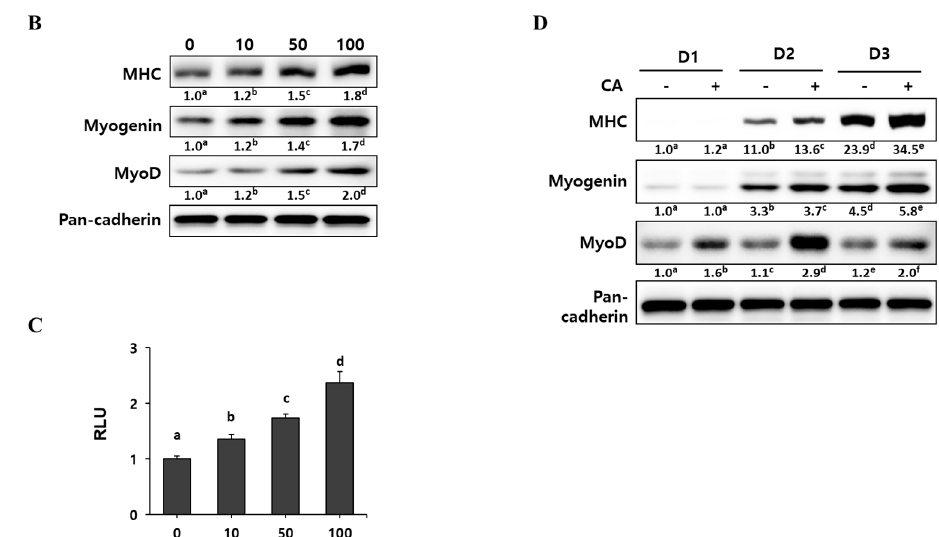
Figure 3. Effect of corylifol A on myogenesis. C2C12 cells were differentiated in the presence of corylifol A (CA, 10, 50 and 100 nM) for 3 days, and then cells were collected to perform ( A ) immunostaining of MHC (red) and DAPI (blue) (scale bar = 200 µm) and ( B ) Western blot analysis to determine the expression of myogenic markers. Values are mean ( n = 3). ( C ) C2C12 myoblasts were transfected with a MyoD-responsive reporter 4RTK-luciferase, and then cells were differentiated in the presence of corylifol A, followed by measurement of luciferase activity. Data are expressed as mean ± S.D. of three independent experiments. ( D ) C2C12 myoblasts treated with corylifol A (100 nM) and harvested on differentiation day 1 (D1), 2 (D2) and 3 (D3) to evaluate the expression of myogenic markers. Values are mean ( n = 3). The images are representative of three independent experiments with similar results. Means without a common superscript differ significantly ( p < 0.05).